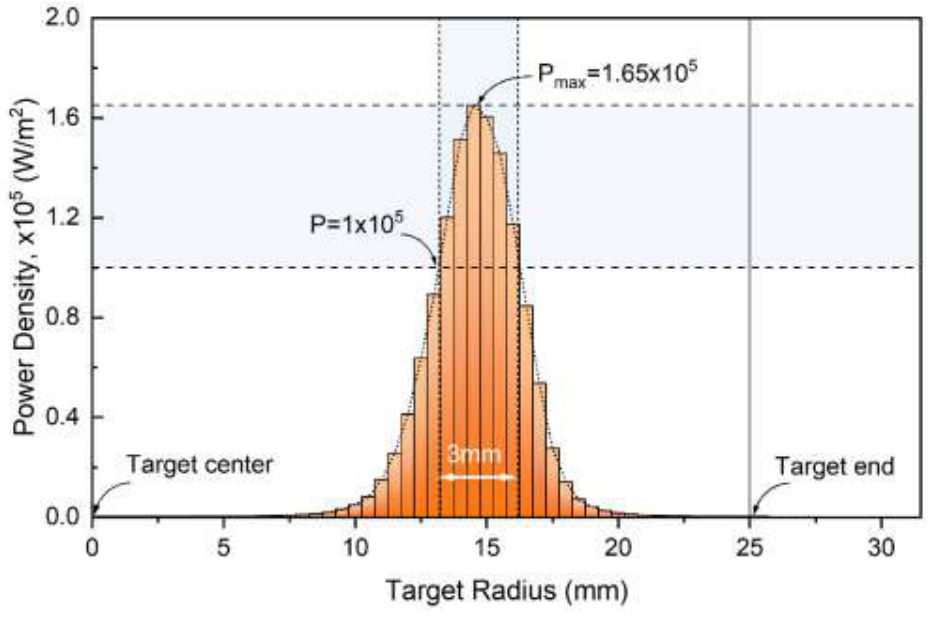
Figure 4: Power density distribution at the surface of the target. The x-axis represents the distance from the center of the